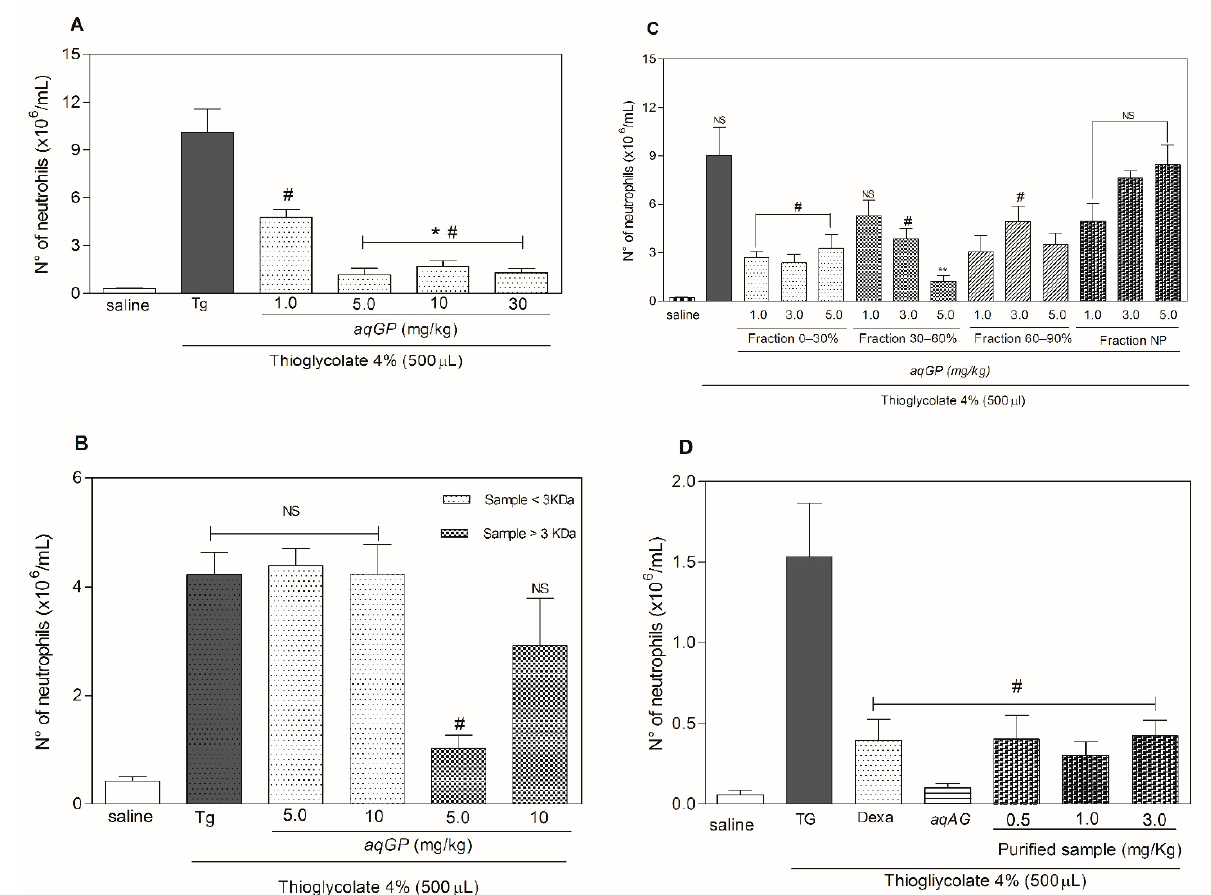
Figure 3. Anti-inflammatory bioassay-guided fractionation of AqGP . ( A ) Neutrophil migration to the peritoneal cavity in mice pre-treated with AqGP . ( B ) The migration of neutrophils to the peritoneal cavity was evaluated for mice pre-treated with fractions of AqGP collected from the ammonium sulfate precipitation process. ( C ) The migration of neutrophils to the peritoneal cavity in mice pre-treated with the peak three fraction (retention 29.9 min) obtained from fractionation by reverse phase chromatography of the 0–30% saturation fraction by ammonium sulfate of AqGP . ( D ) Anti-inflammatory activity after rechromatography in a hydrophobic affinity column of C4. Each experimental group had n = 5. Results are expressed as mean ± SEM of the number of neutrophils per mL. # p < 0.05 difference as compared to the untreated group injected with thioglycolate; * p < 0.05 difference as compared to the group treated with aqGP 1.0 mg/kg; ** p < 0.05 difference as compared to the group treated with aqGP fraction 0–30% (ANOVA followed by Bonferroni’s test); NS: not significant.